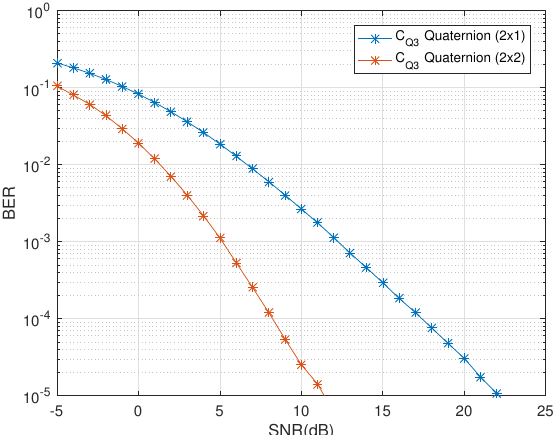
Figure 7. BER vs. SNR performance of C Q